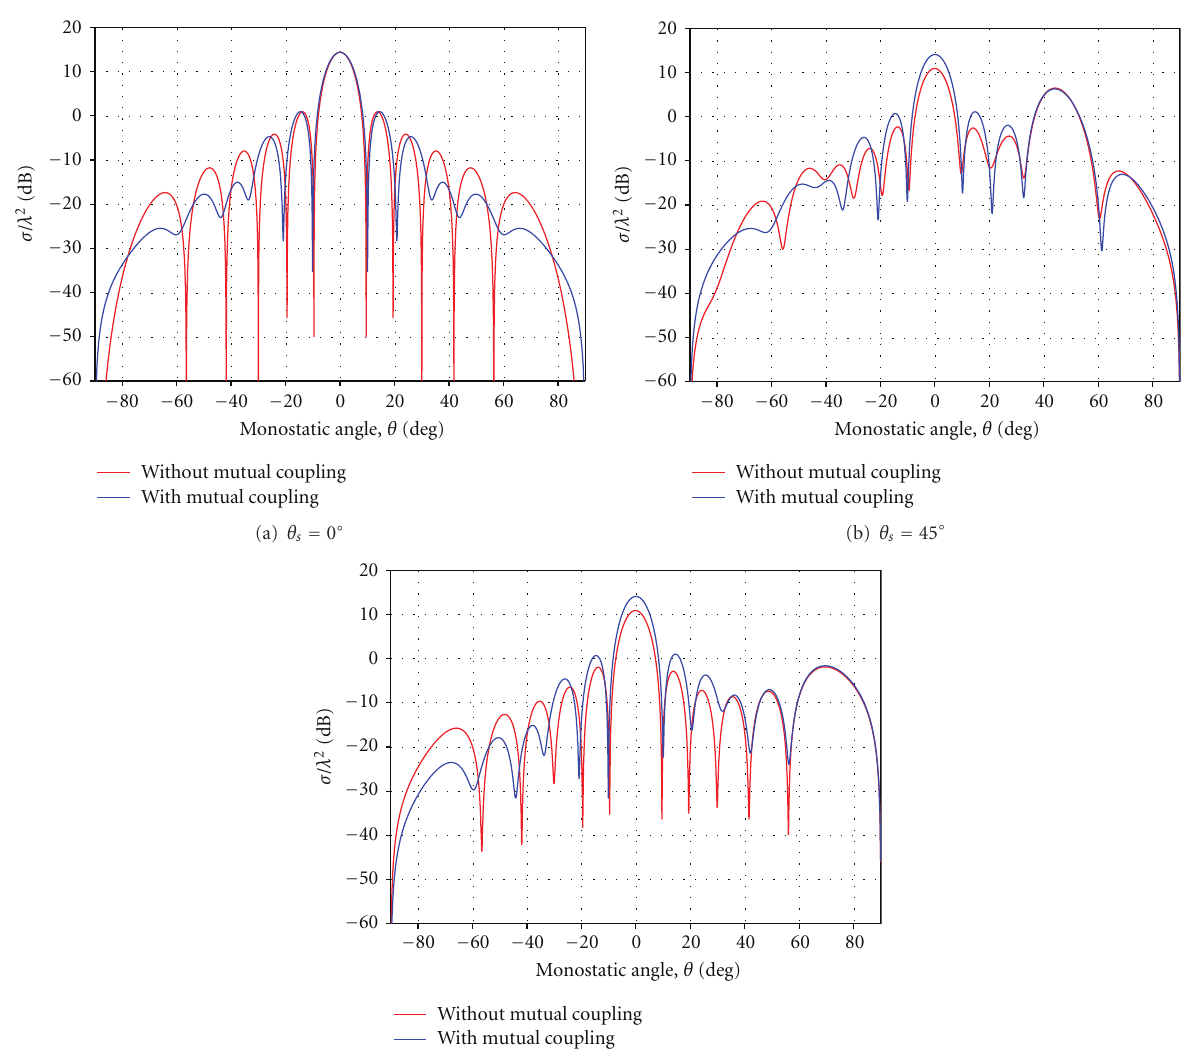
Figure 20: E ff ect of mutual coupling on RCS of series-fed linear side-by-side dipole array of N = 30, ψ = π/ 2, d = 0 . 1 λ , l = 0 . 5 λ , a = 10 − 5 λ , Z 0 = 150 Ω , and Z l = 280 Ω ; unit amplitude uniform distribution.